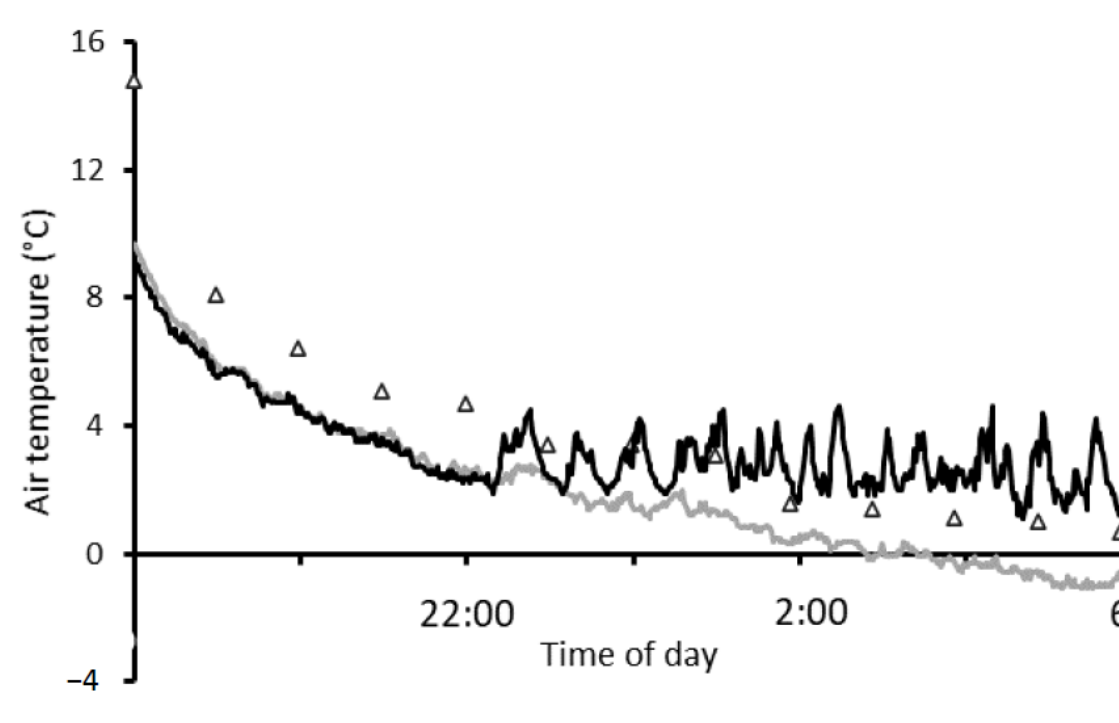
Figure 6. A typical frost event temperature profile depicting hourly (7 p.m. to 7 a.m.) screen air temperature (triangles—1200 mm above ground level—AGL from the onsite weather station) and minute canopy air temperature (an unshielded thermocouple 800 mm AGL T-type, Temperature Controls Pty. Ltd., Sydney, NSW, Australia) heated (black line) and non-heated (grey line) during heading of mid-May sown Wyalkatchem (Z55) on 7 September 2019.